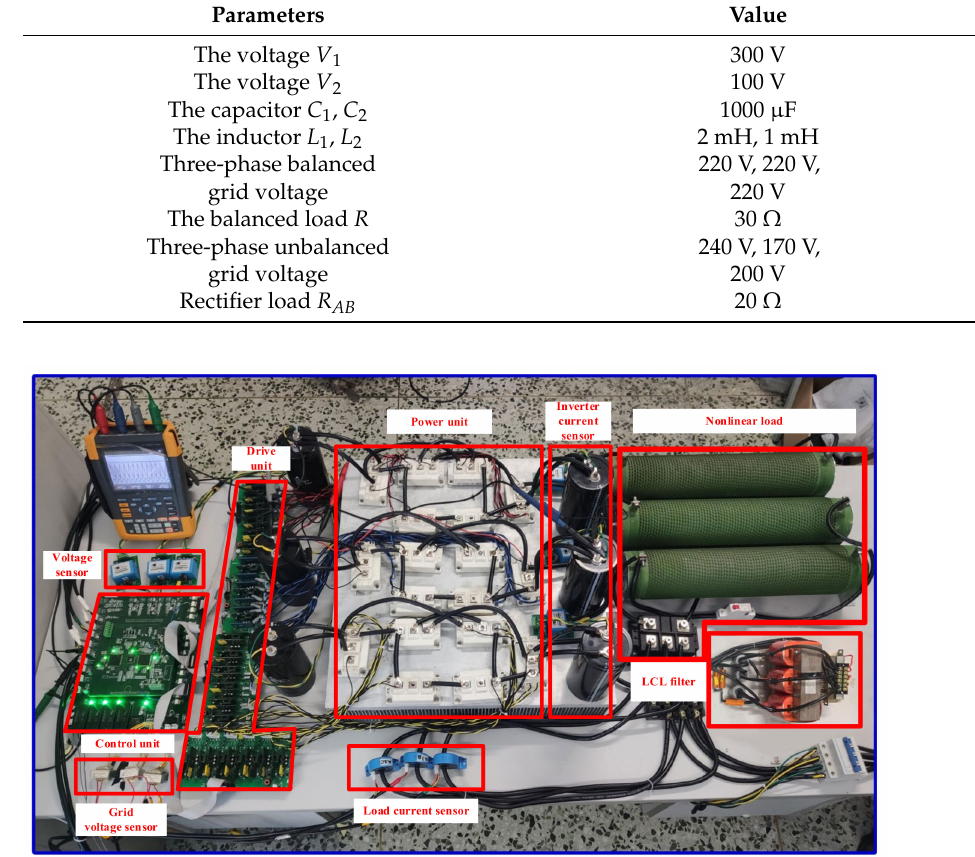
Figure 20. Experimental